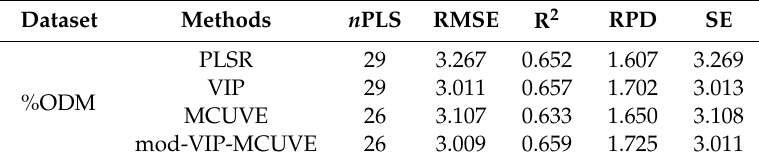
Table 2. The RMSE, R 2 , RPD, and SE in variable selection methods using %ODM data.